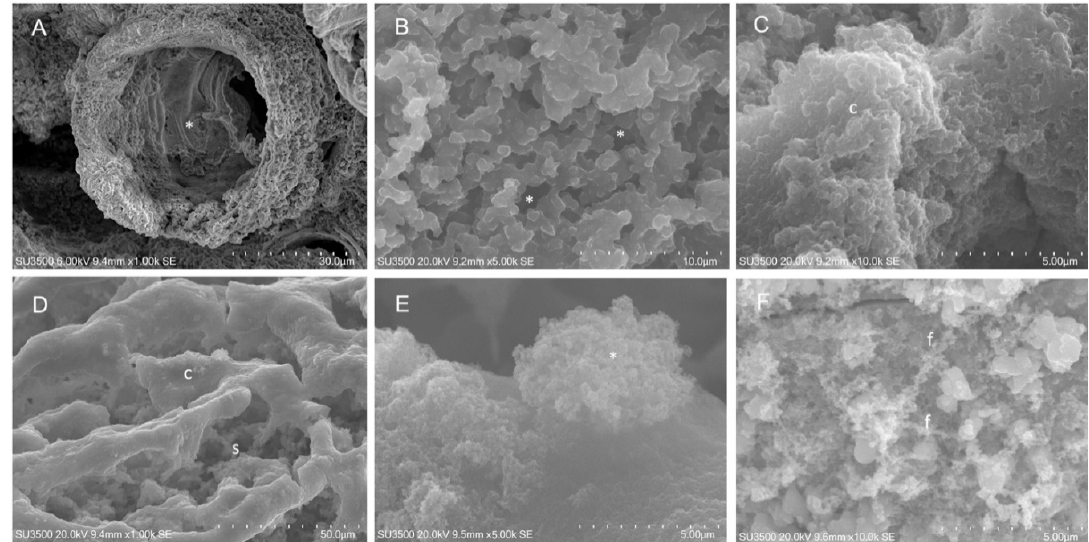
Figure 5. SEM analysis on S. aureus 5S. Untreated S. aureus 5S: ( A ) SEM, 1000×. Biofilm showed microchannels (asterisk). Biofilm surface was compact and rough; ( B ) SEM, 5000×. Inner areas with spongy structure. ( C ) SEM, 10,000×. Sometimes, inner dense areas with compact arrangement were observed. S. aureus 5S after exposure to EO45 1.00% v / v : ( D ) SEM, 1000×. Compact areas flakes off, allowing inner spongy structure to appear. ( E ) SEM, 5000×. High magnification showed signs of EPS disintegration in the way of a bush-like floccular aggregate (asterisk). ( F ) SEM, 10,000×. Very high magnification shows trabeculae flaking in fine filaments. f: filaments; s: sponge; c: caves.